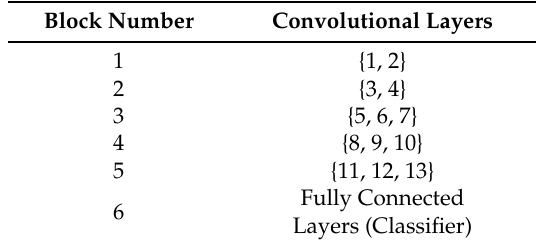
Table 1. VGG16 Network: block structure and convolutional layers